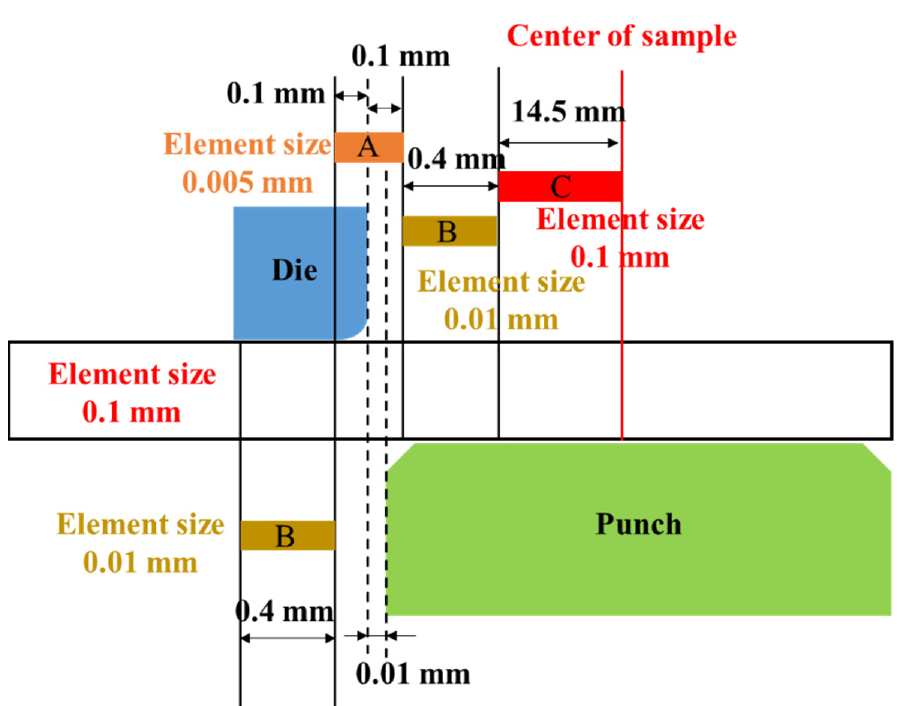
were represented as 2D analytical rigid bodies.